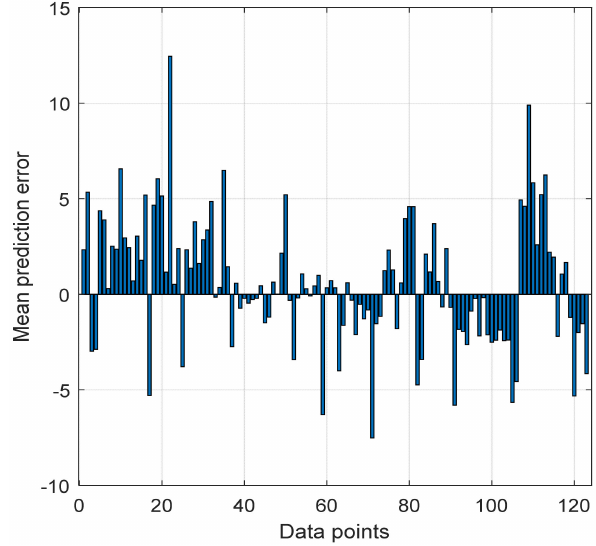
Figure 19. Mean prediction error statistics along with Data points in site 2.